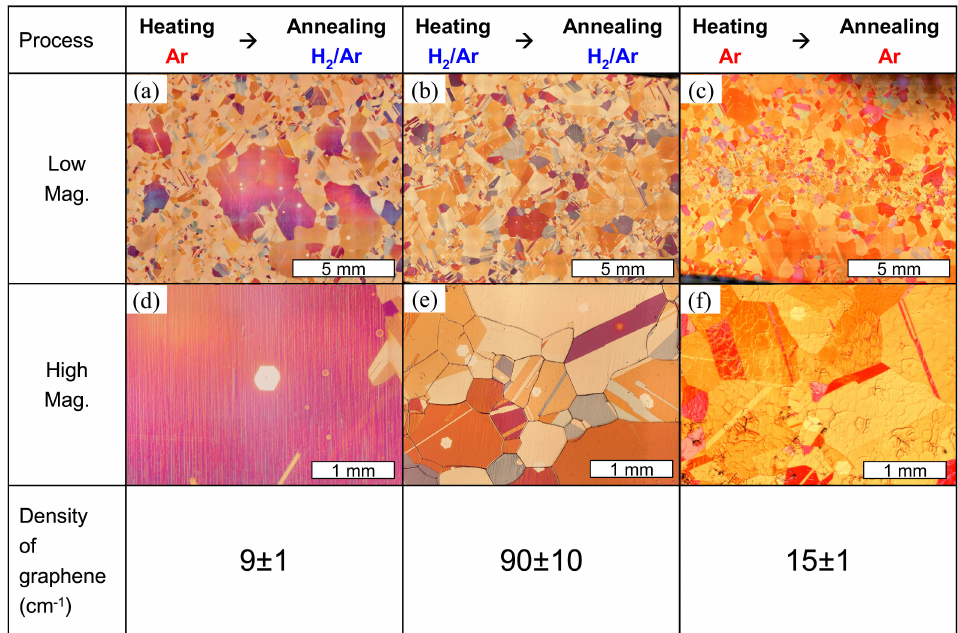
Figure 6. Effect of gas ambient on the heating and annealing process before Ar annealing on the morphology of Cu and the density of graphene. Low ( a – c ) and high magnification ( d – f ) optical microscope images of CVD graphene on Cu obtained by the Ar heating followed by H 2 /Ar ( a , d ); heating and annealing in H 2 /Ar ( b , e ); and heating and annealing in Ar ( c , f